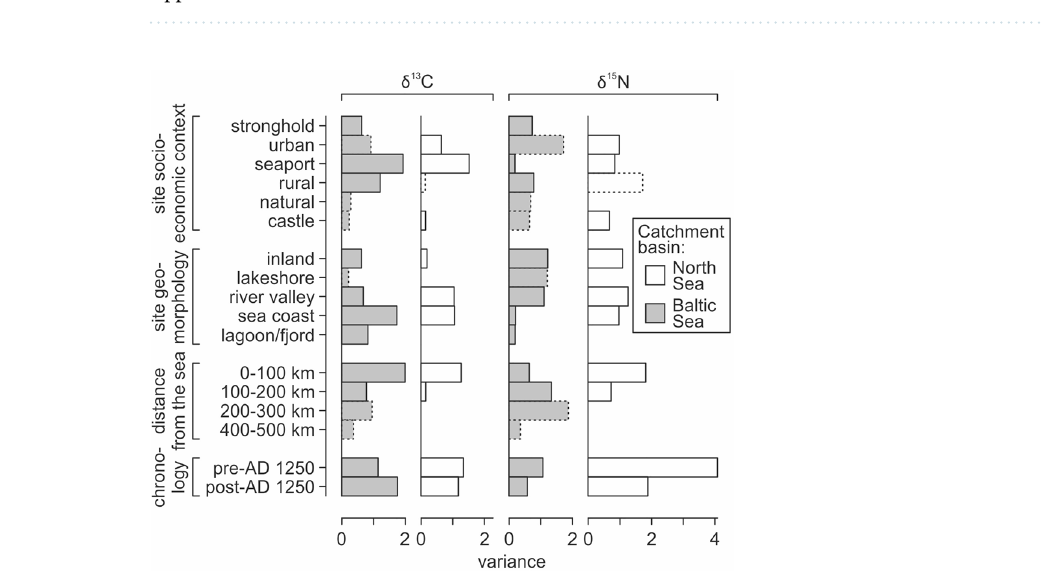
Figure 5. Variability of δ 13 C and δ 15 N values in medieval and post-medieval cats grouped by: ( a , b ) site socio- economic context; ( c , d ) site geomorphology; ( e , f ) pre- and post-AD 1250 chronology. For detailed values see SI Appendix Tables S1, S4–S7.